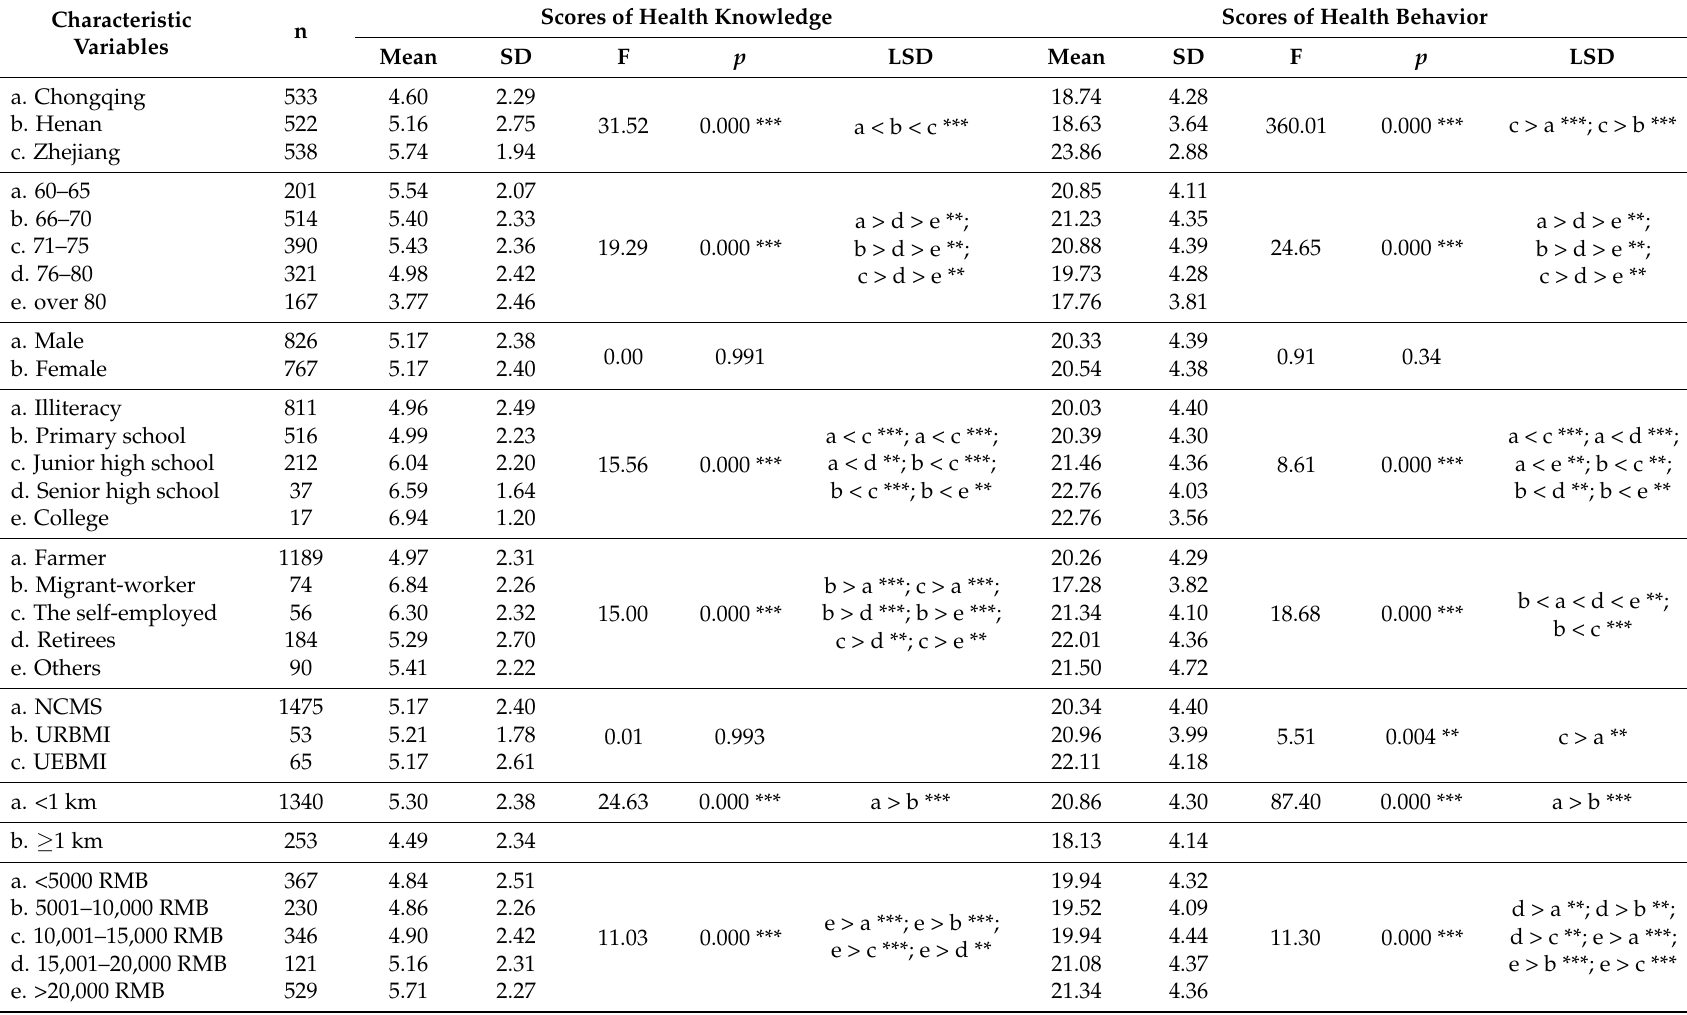
Table 4. Scores of health knowledge and health behavior under different items of the elderly in sample